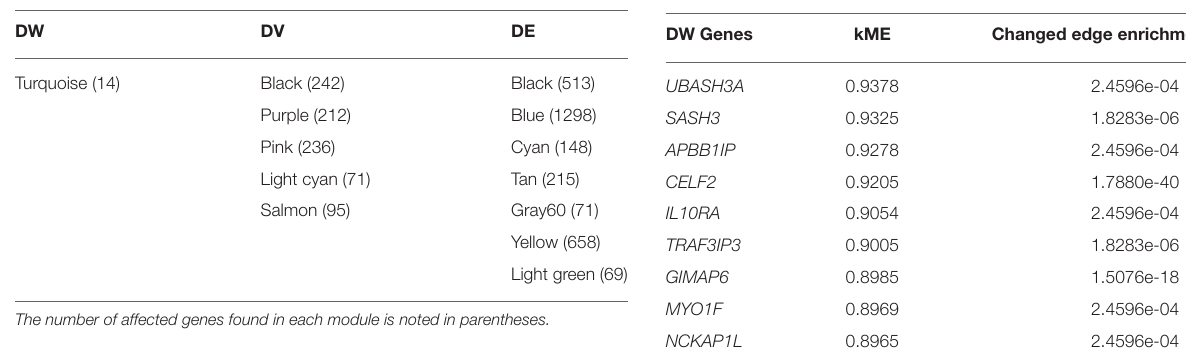
TABLE 1 | Summary of identified consensus modules enriched in affected genes via differential network analysis between progressor and non-progressor conditions.